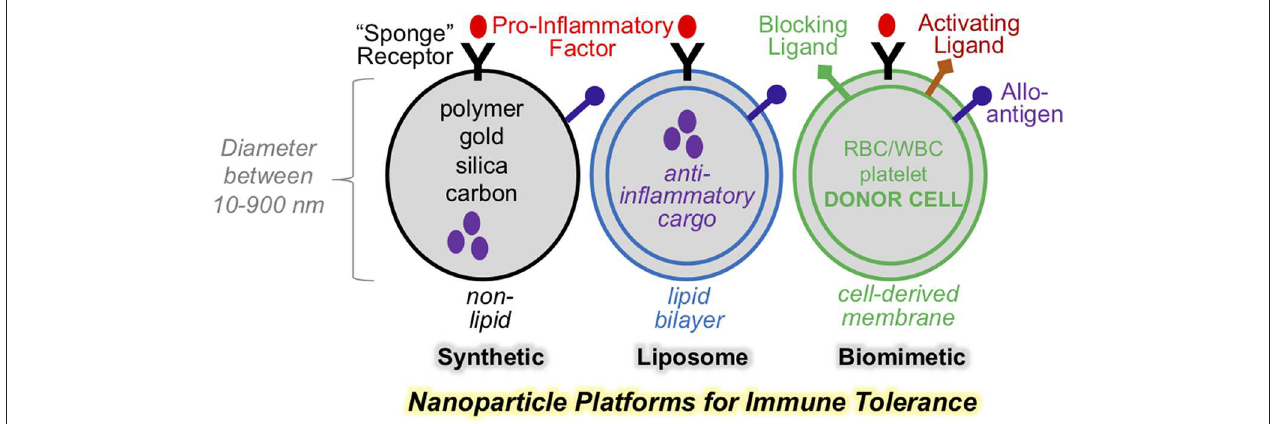
FIGURE 1 | Nanoparticle platforms for various designs for immune regulations. Selection nanoparticle physical properties is key to effective therapeutic targeting. Synthetic and liposome-based nanoparticle may be engineered to display surface ligands, as well as encapsulate bioactive cargo. Biomimetic nanoparticle incorporate cell-derived membranes and heterogenous composition of surface and functional ligands with the capacity to avtive or block signaling on cellular